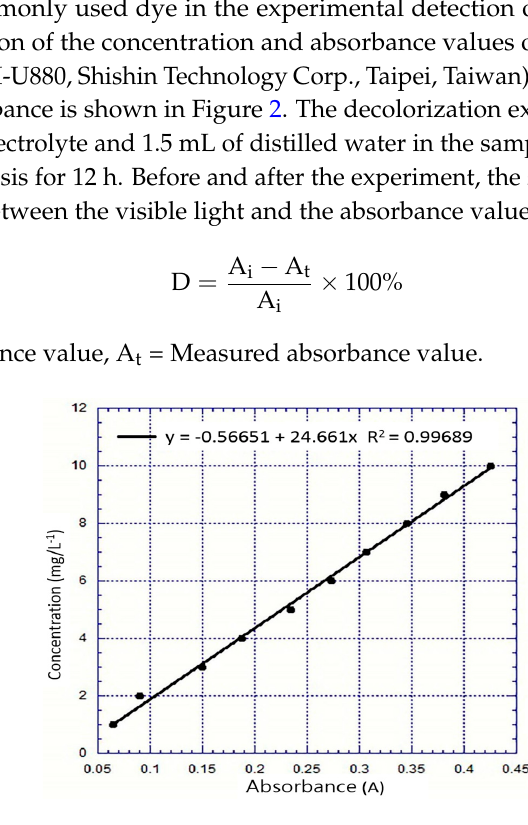
Figure 2. Plot of RB5 concentration vs. absorbance value in aqueous solution analyzed using a spectrophotometer.